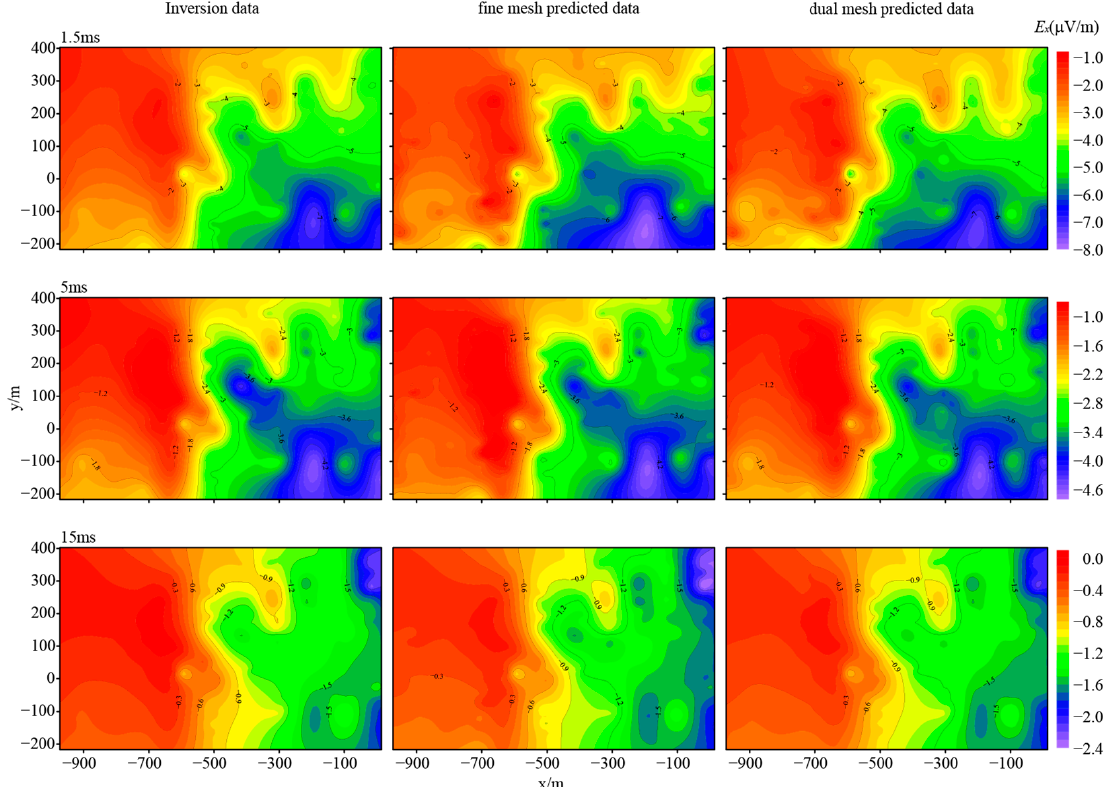
Figure 11. Borehole data fitting for dual-mesh and conventional methods.